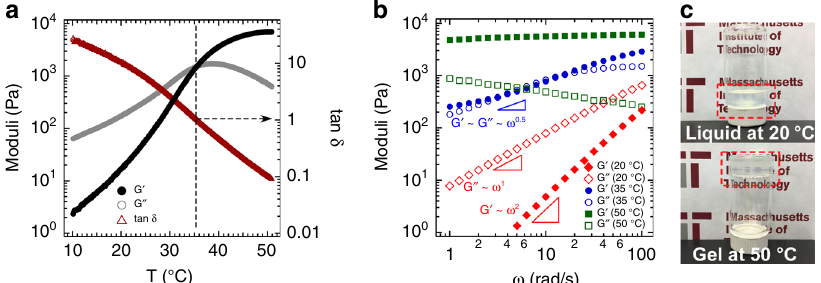
Fig. 2 Rheological behavior of thermogelling nanoemulsion-based gel. The canonical system contains 20% isopropyl myristate as the oil phase, 20% surfactant as an emulsi fi er (a mixture of Tween 80 and Span 80 with HLB = 13), 5% PEG 400, 4.7% Pluronic (F127/F68: 6/1 g/g), and 50.3% DI water. All concentrations are in mass percentage. The droplet volume fraction, ϕ , is 0.24, and the hydrodynamic oil droplet diameter is 53 nm. a Evolution of the dynamic moduli in a small amplitude oscillatory shear temperature ramp experiment from 10 °C to 50 °C with a ramp rate of 2 °C/min. The dashed line indicates where G ′ and G ″ intersect. b Linear viscoelastic spectra at different temperatures. c Optical images of inverted glass vials containing sample below (20 °C) and above (50 °C) the gelation